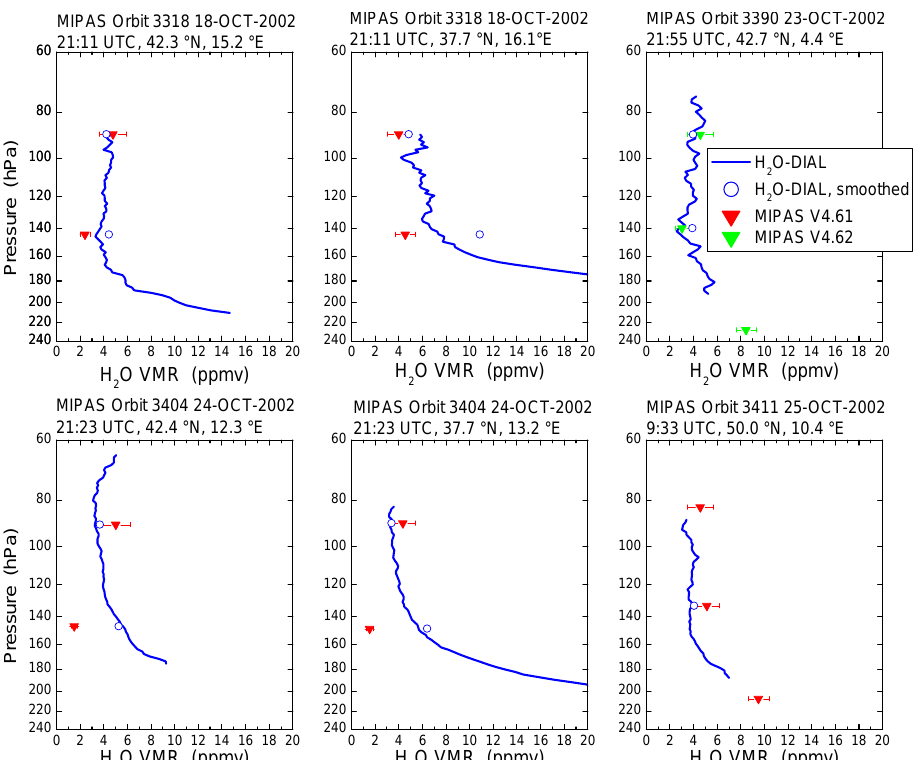
Fig. 10. Comparison of observed H 2 O-DIAL profiles (blue solid lines and circles) and MIPAS H 2 O data points version 4.61 (red triangles) and, in one case, version 4.62 (green triangles). H 2 O-DIAL profiles have been smoothed with the averaging kernel of MIPAS.